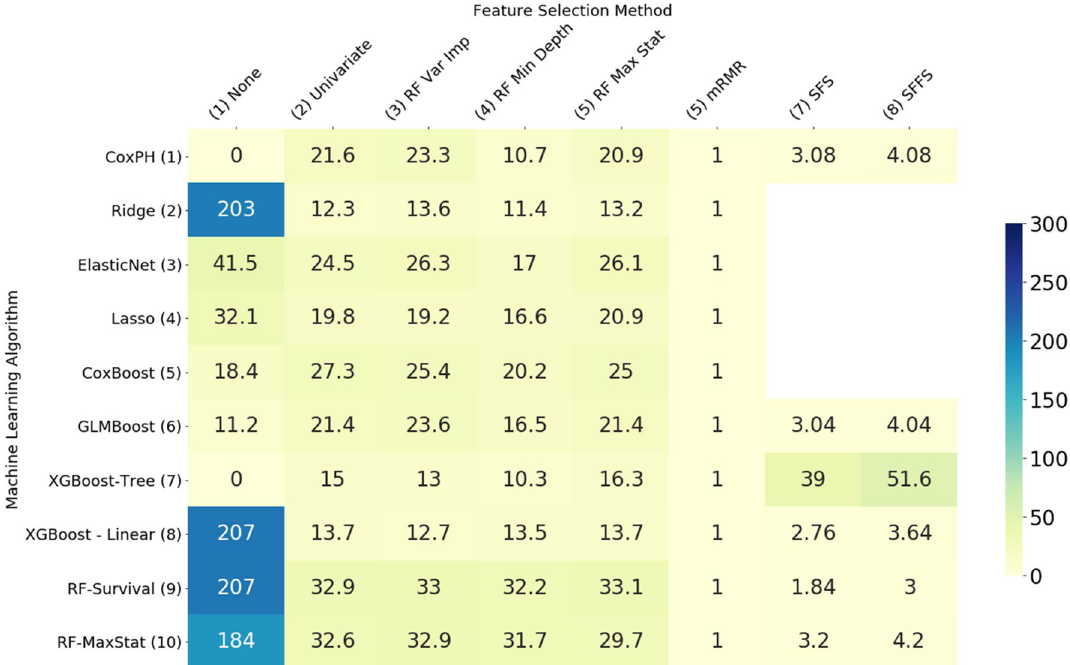
Figure 4. Average number of features selected by each model—ADNI